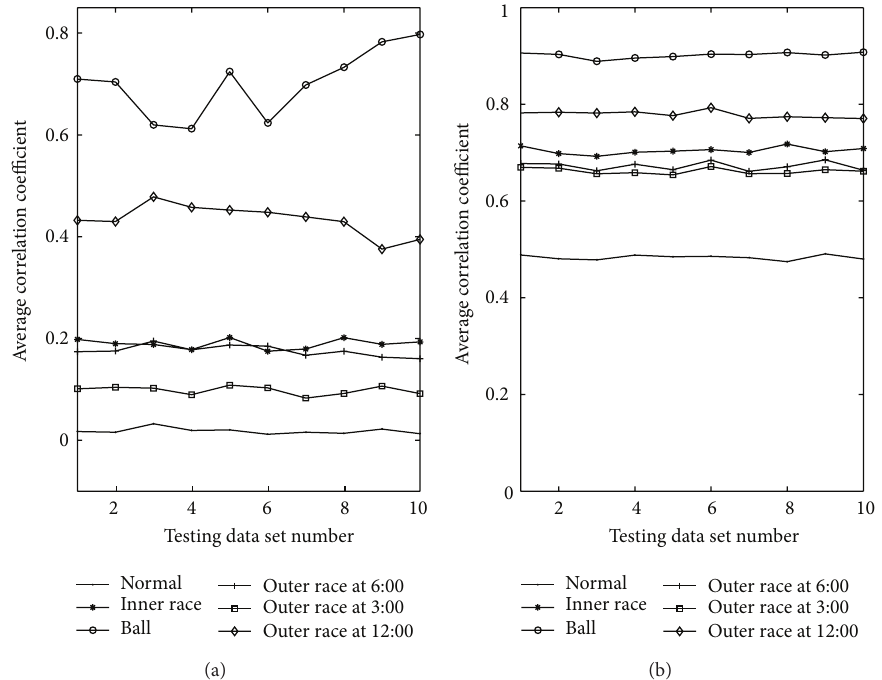
Figure 6: Detection results of data set A with a ball fault according to morphology spectrum correlation analysis: (a) signal based triangular SE; (b) flat SE.